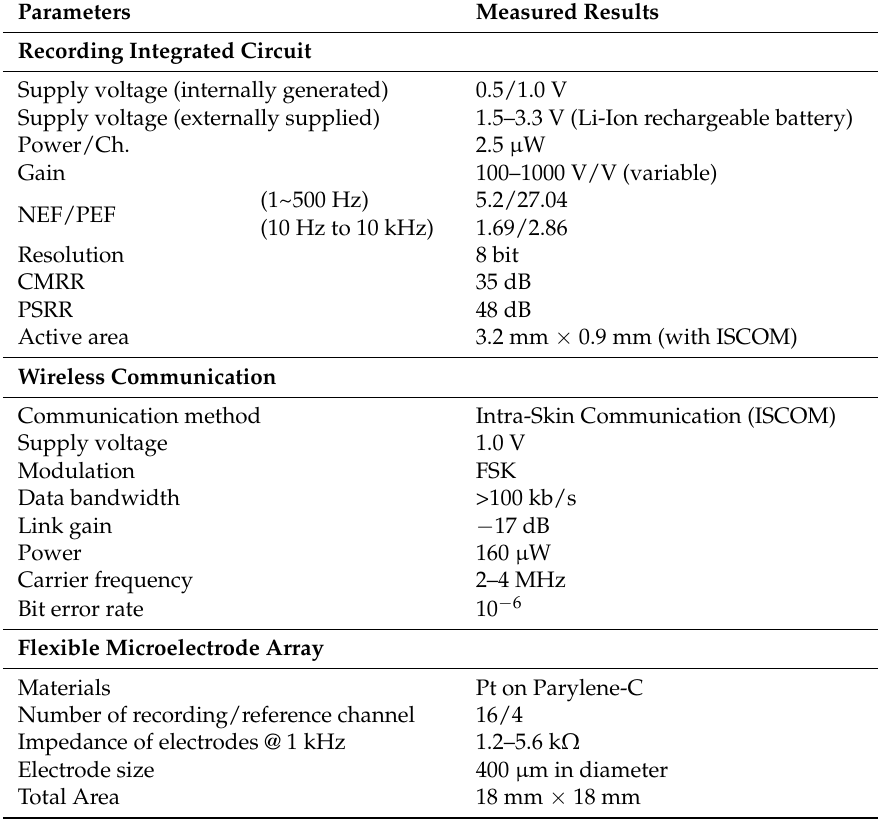
Figure 13. Microphotograph of the fabricated neural interface circuit chip. Table 1. Summary of characteristics of the fabricated IC and microelectrode array.